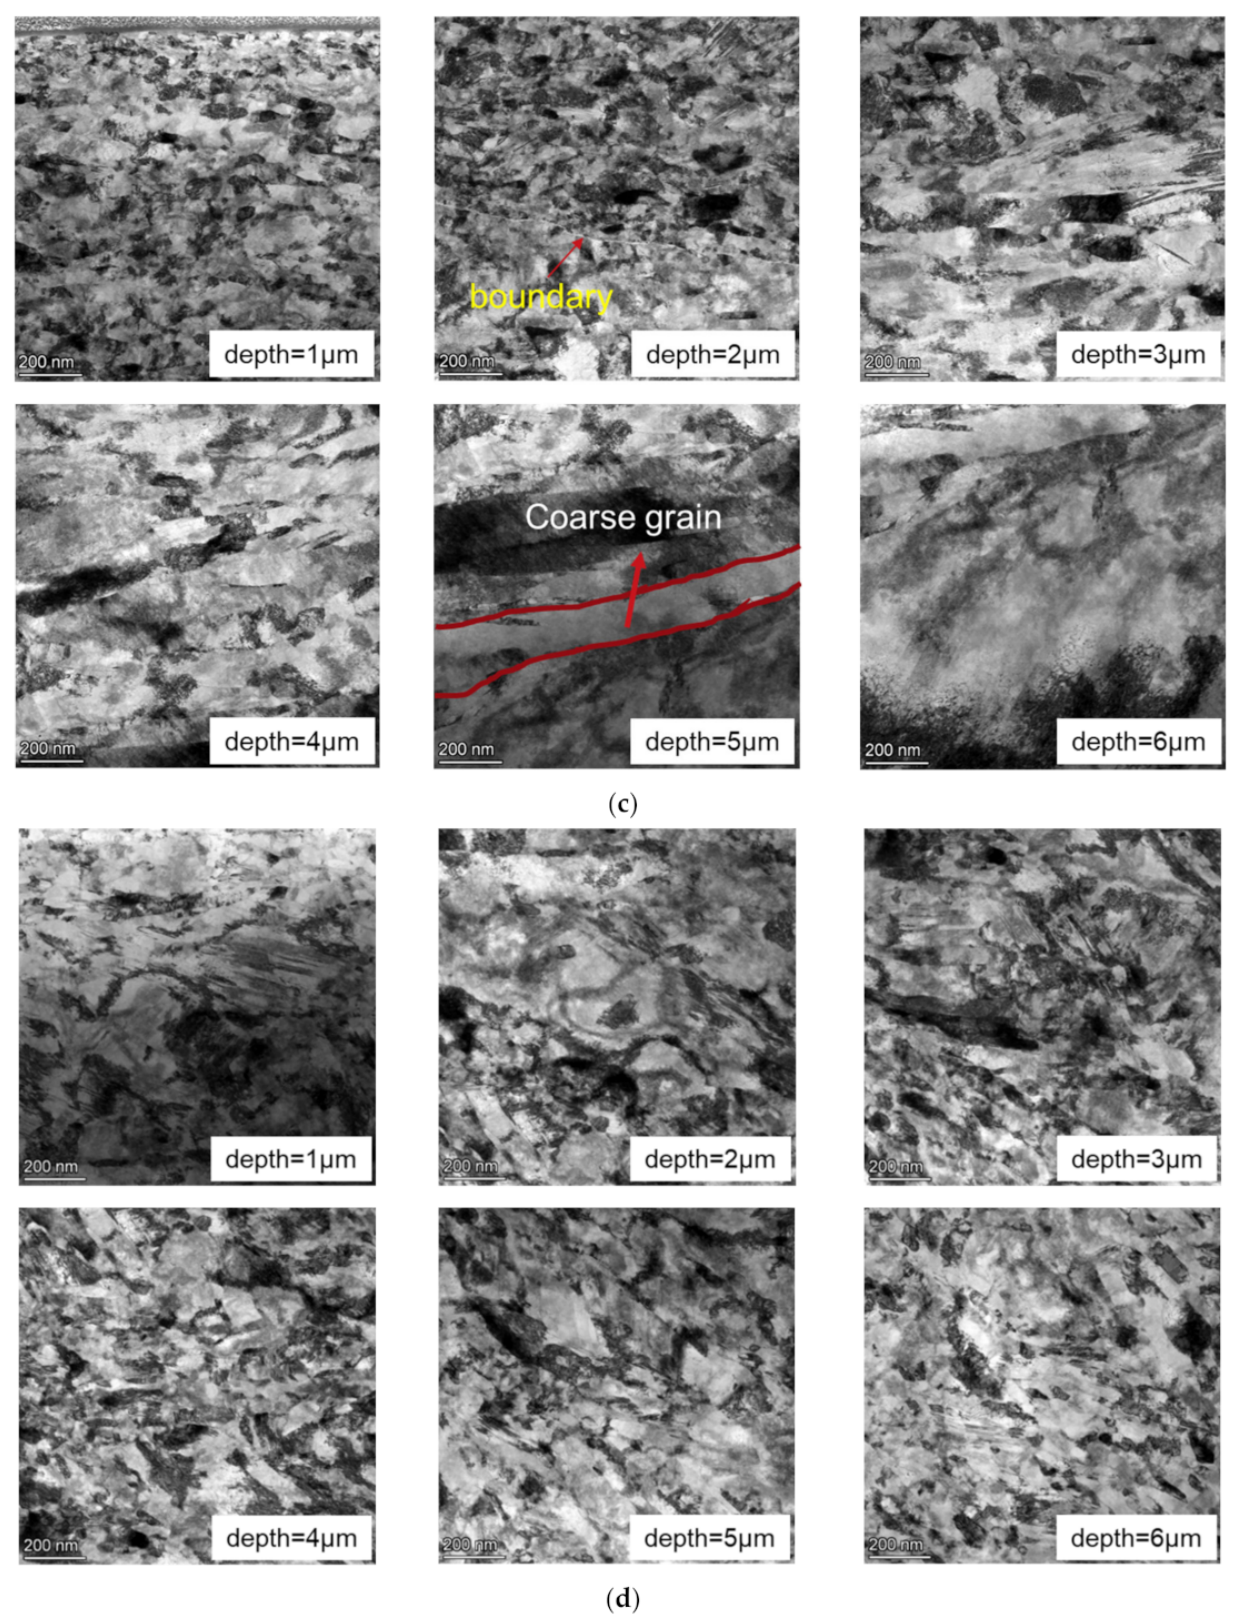
Figure 7. TEM micrographs: ( a ) grain size variation in depth direction of specimen with LSP, ( b ) grain size variation in depth direction of specimen without LSP, ( c ) grain character at different depth of specimen with LSP, and ( d ) grain character at different depth of specimen without